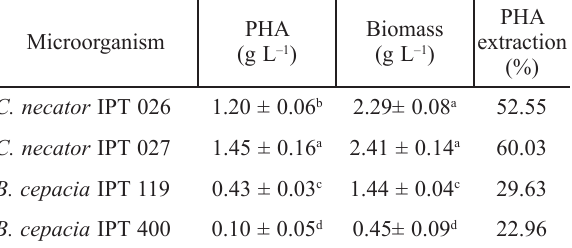
Averages followed by different letters, in the upper right, show differences between strains in the same column, determined by Tukey’s test ( P